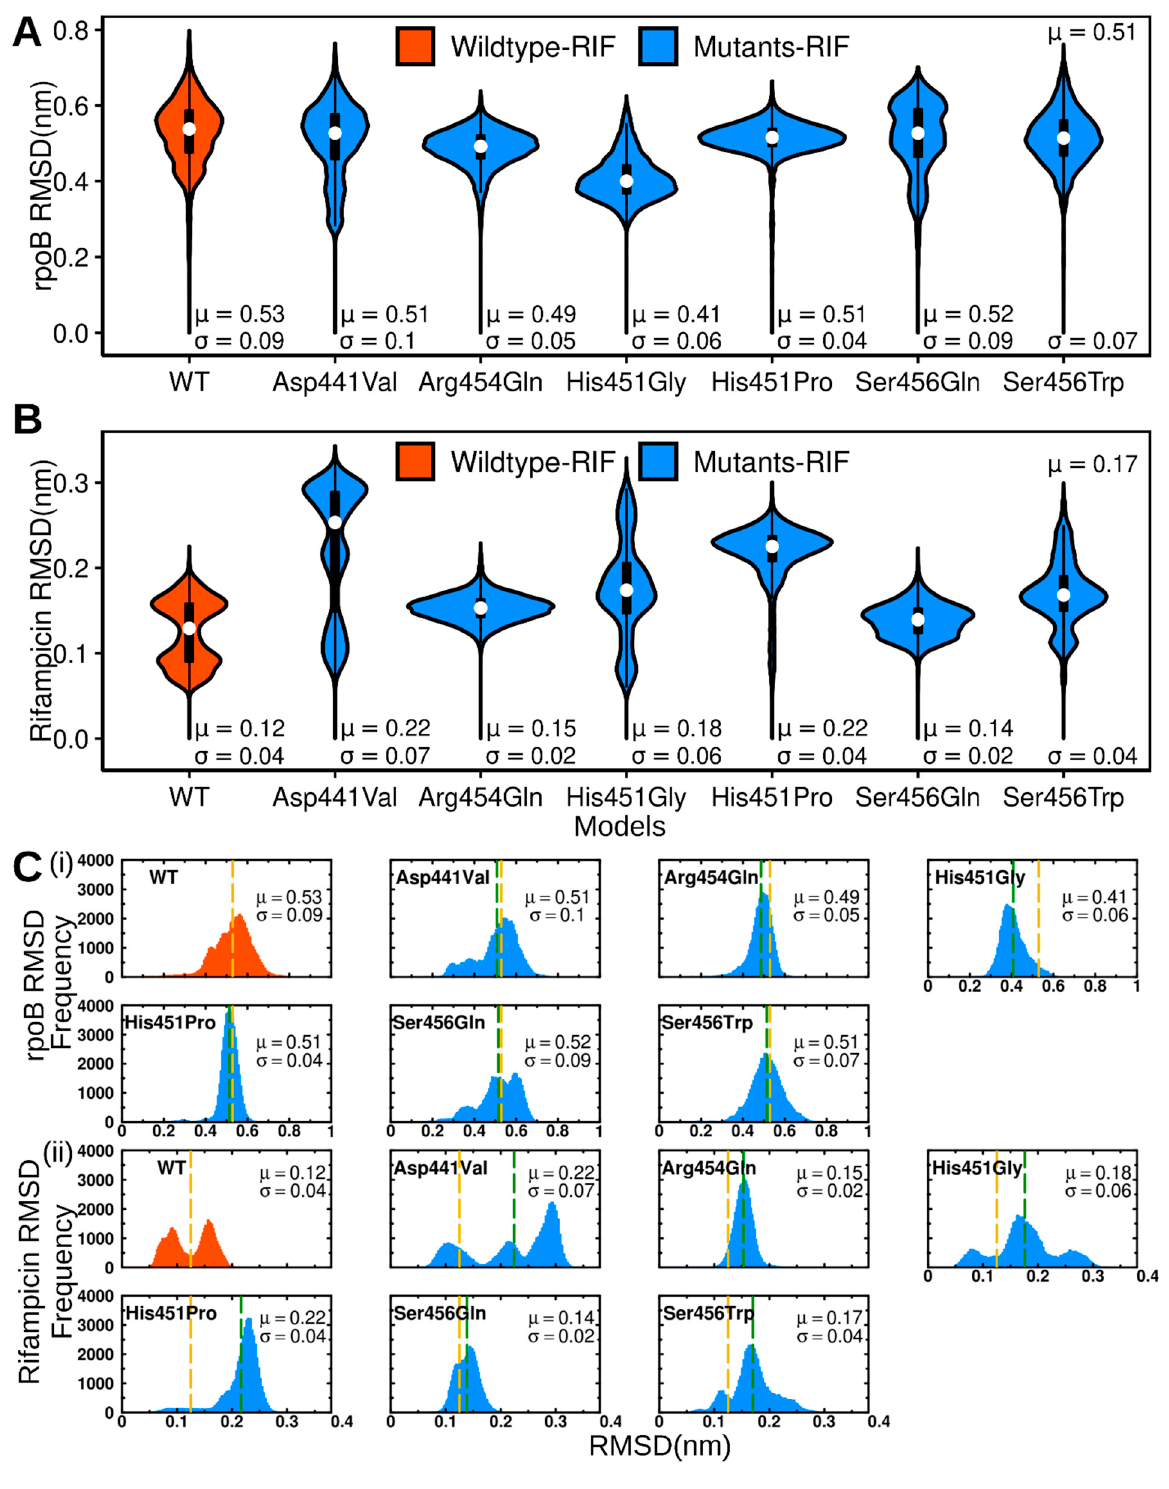
Figure 3. Violin plots illustrating the kernel density distribution frequency of ( A ): Protein RMSD, ( B ): Ligand RMSD. Color key: Red: bound WT, Blue: bound mutants. Embedded boxplots highlight the data distribution (25th (bottom) and 75th (top) percentiles). The white dot indicates the median value. ( C ) ( i ) and ( ii ). Histogram representation of RMSD distribution for ( i ) the protein, and ( ii ) RIF. Color key: red: bound WT, blue: bound mutants. The mean RMSD value is highlighted as dashed lines: yellow: representing the WT, and green: representing mutants.